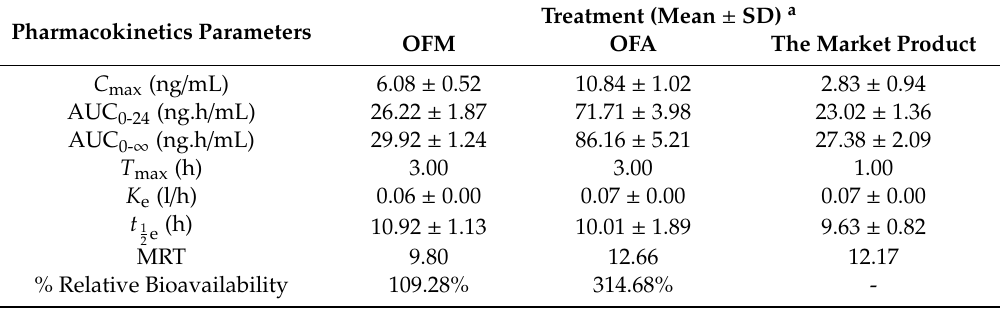
a Median of Tmax and MRT are displayed instead of the mean